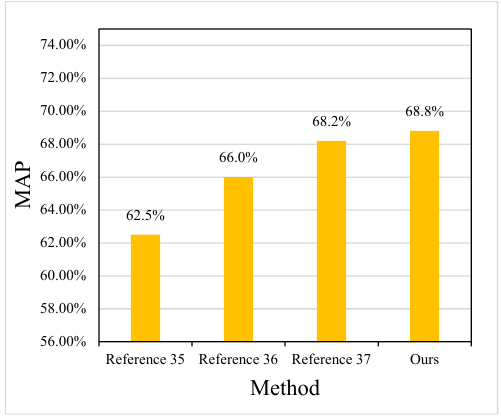
Figure 9. MAP performance of datasets. Table 7. Ablation experimental results.